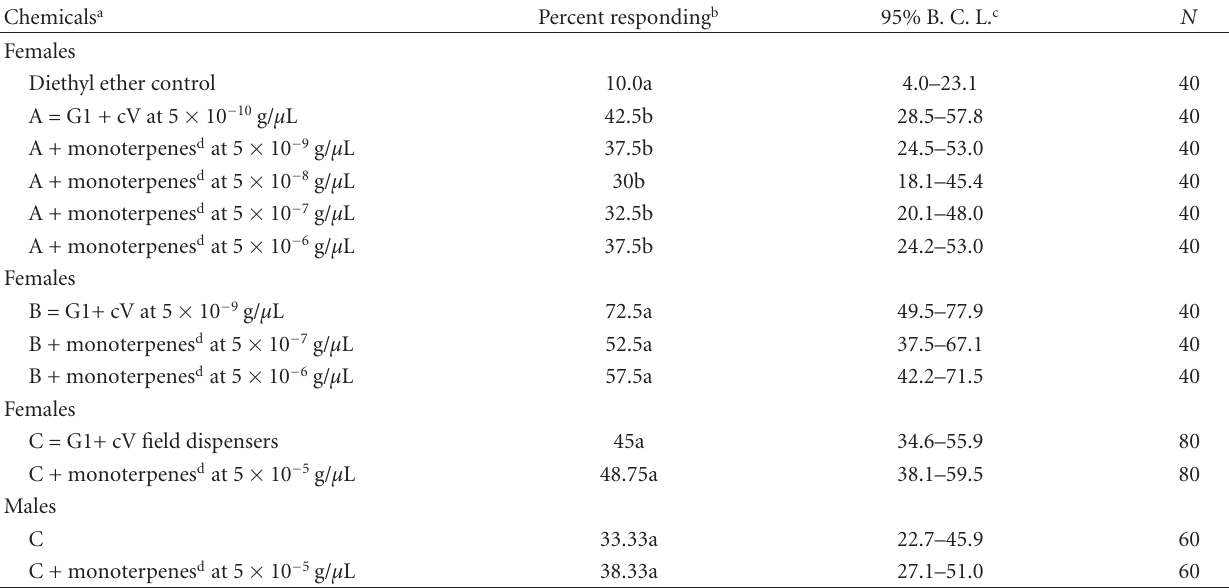
Table 1: Percent of walking Pityogenes bidentatus females and males responding in a laboratory olfactometer (4 May 1999) to conifer monoterpenes and aggregation pheromone components (G1 = grandisol, cV = ( S )- cis -verbenol).